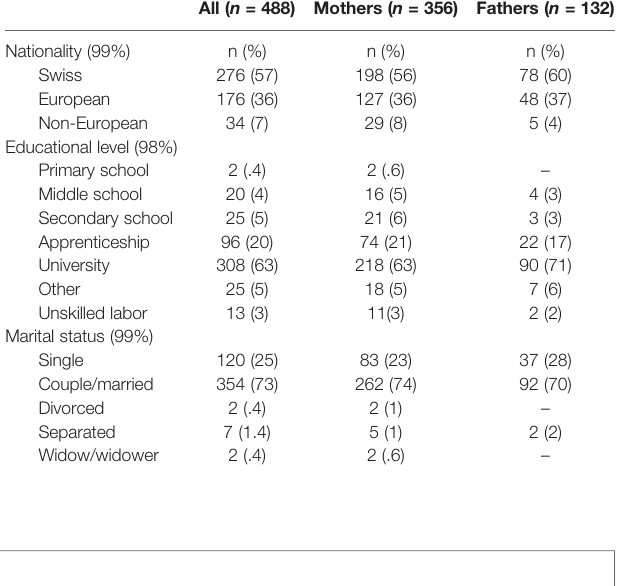
TABLE 1 | Demographic data of the sample by gender of